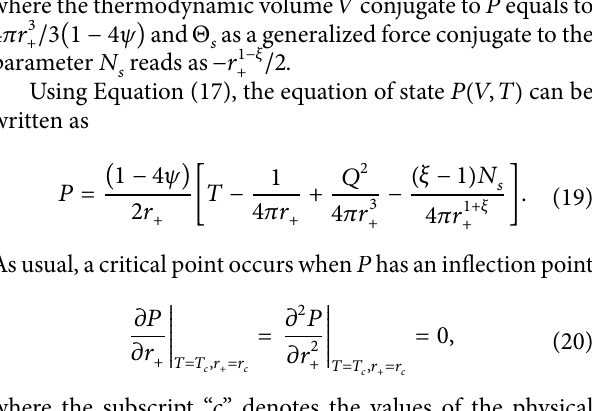
and 𝑇 diagrams with 푄 = 0.1 − ln 𝑟 ) − ln 𝑟 𝑐 𝑐 𝑐 𝑐